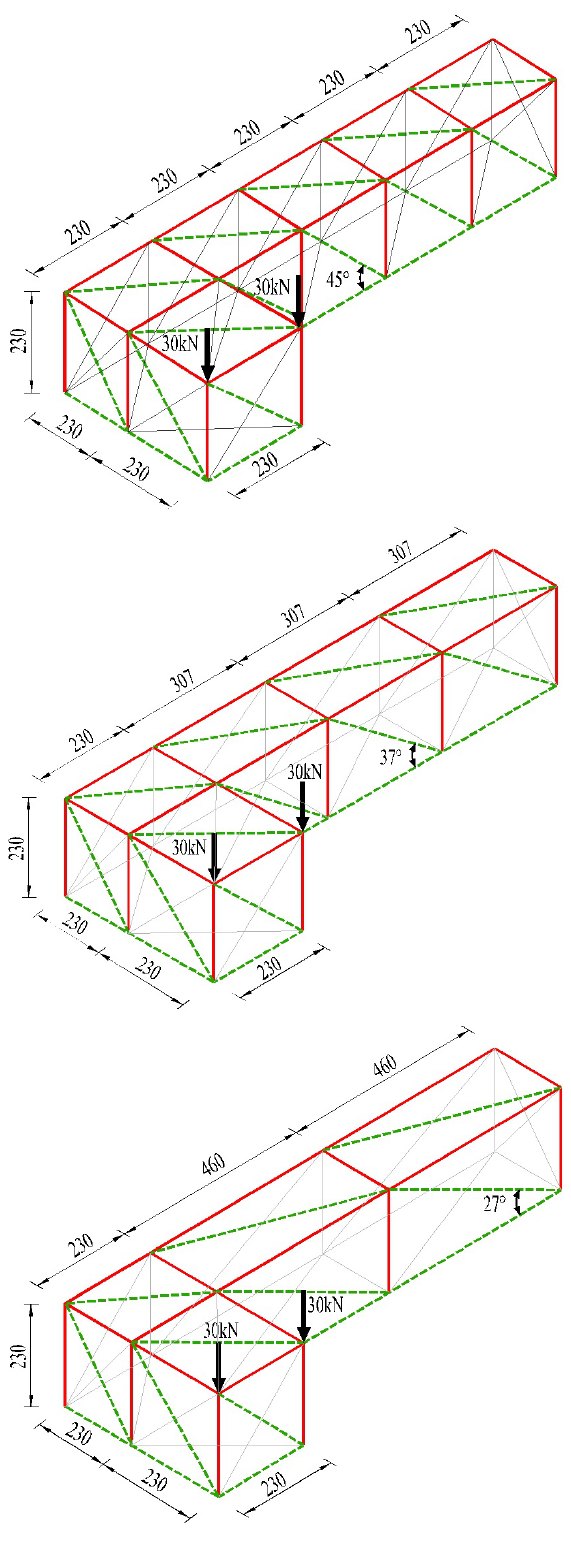
Figure 3: The analysed model of cantilever beams, a) beam B1, b) beam B2, c) beam